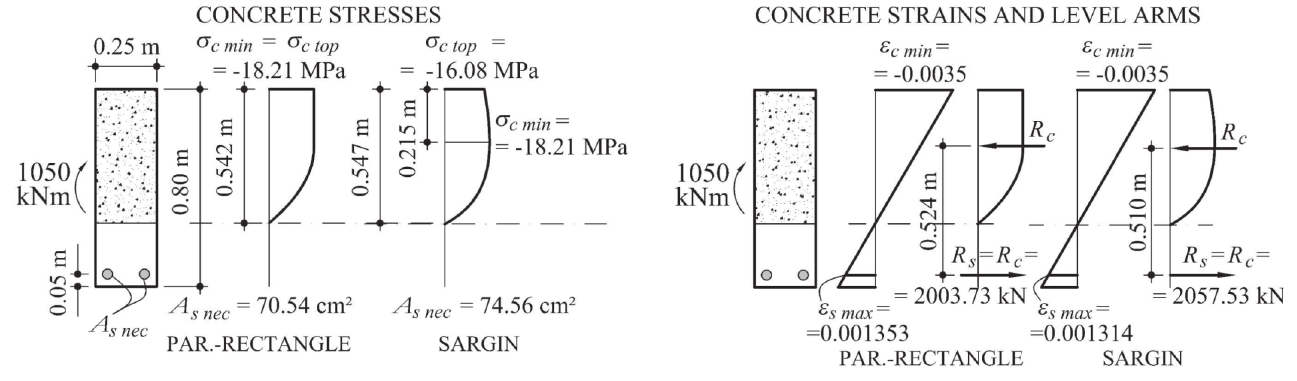
(e = b ⁄4, f = 30 MPa and A z z ck